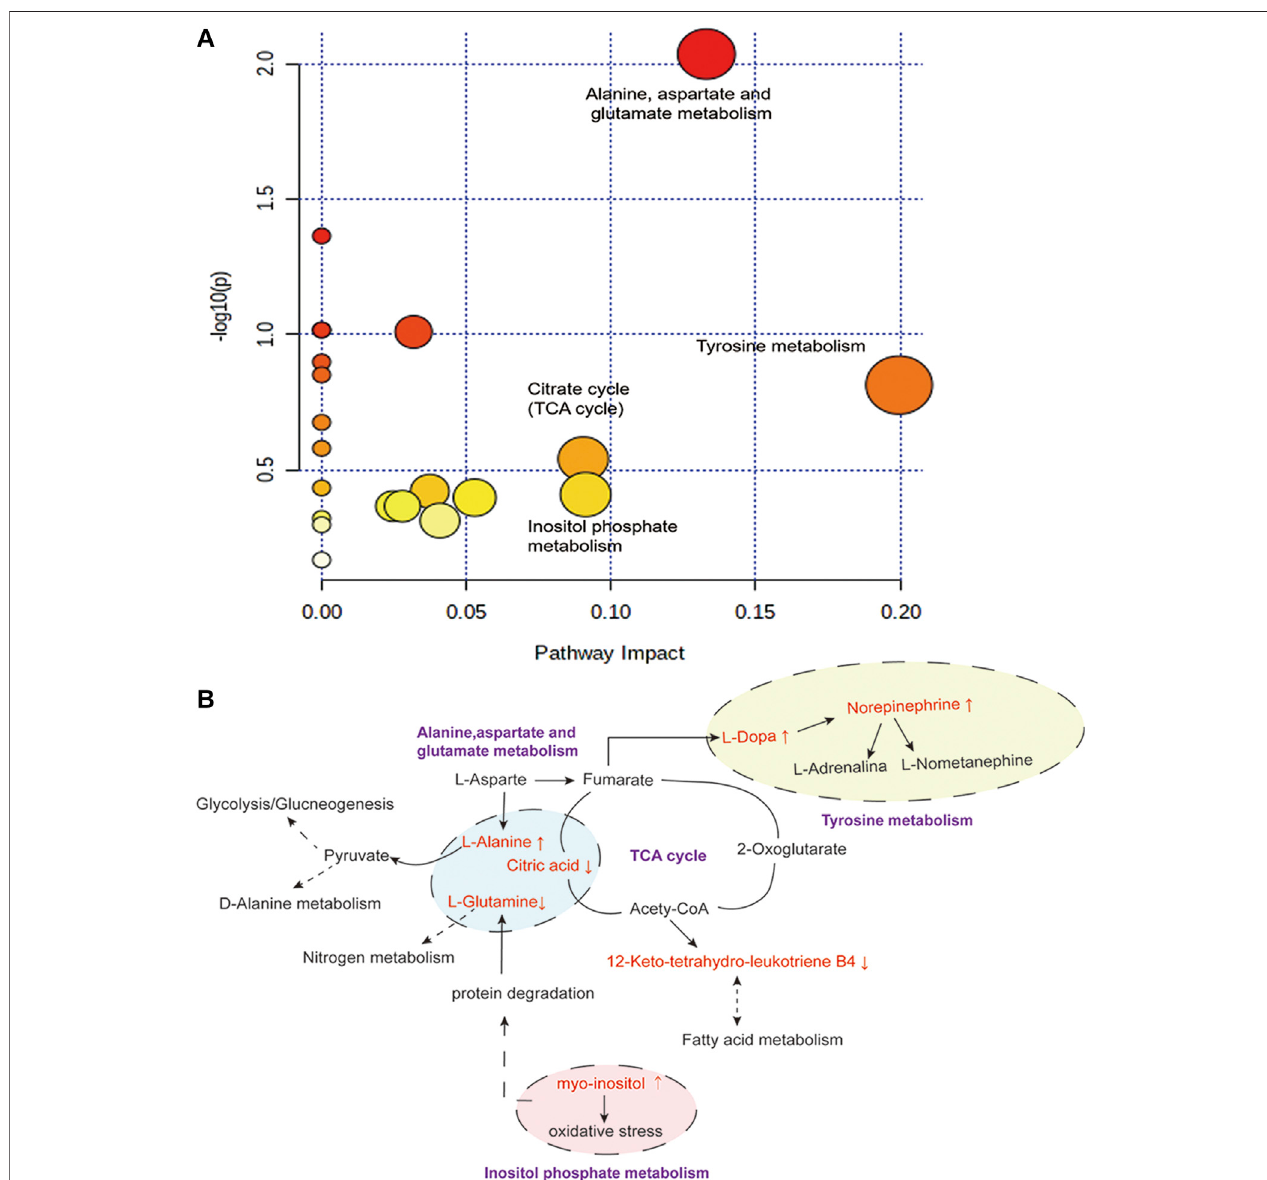
FIGURE12| DisturbedpathwayinresponsetoAH-induced thrombosisandLEOtreatment. (A) Summaryofpathway analysiswithMetabo-Analyst. (B) Metabolic pathways (purple bold) participating in the anti-thrombosis process of LEO against AH-induced thrombosis in zebra fi sh. The metabolites (red) were the identi fi ed biomarkers in the present study. Compared with the control group, the up-regulation is represented by ↑ , and the down-regulation is represented by ↓ .